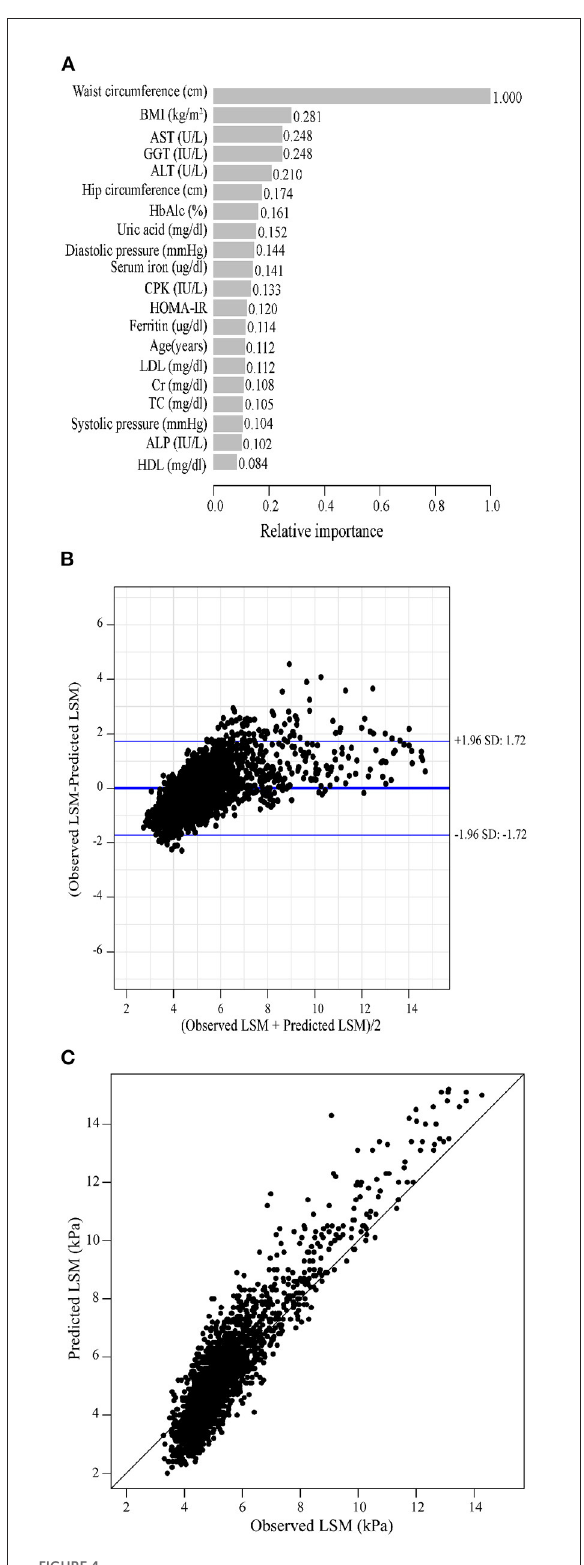
FIGURE4 XGBoost machine learning model developed with dataset C in the training cohort. (A) Relative importance of the top